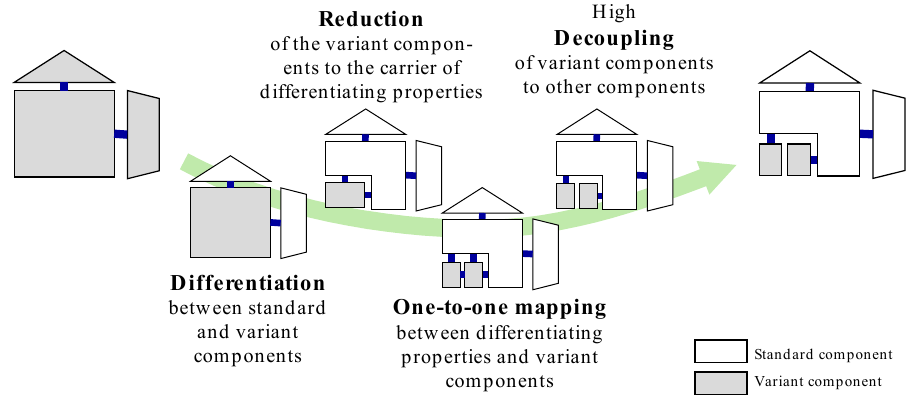
Figure 2. Ideals of variety-oriented product design.